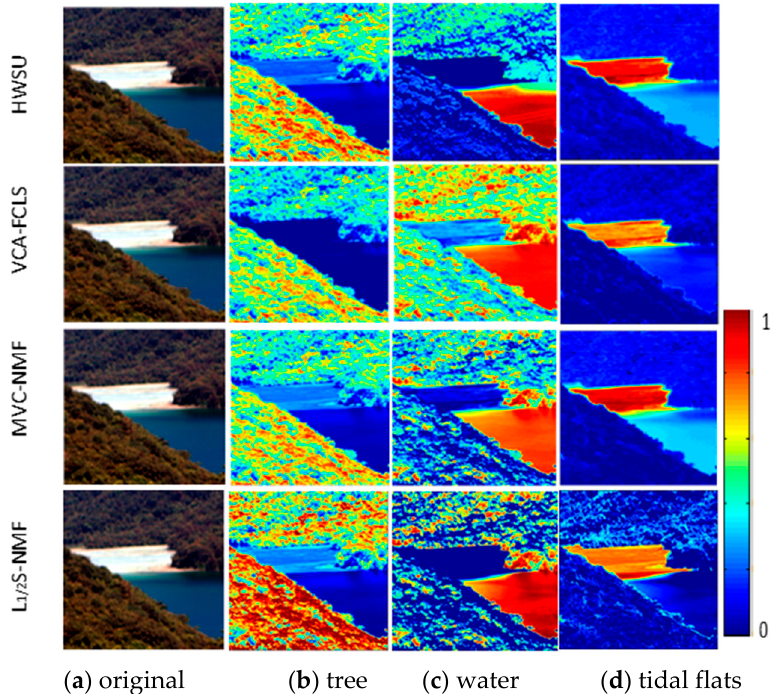
Figure 11. Abundance fraction results of Data 2 estimated by HWSU, VCA-FCLS, MVC-NMF, L 1/2 S-NMF: ( a ) original image, ( b ) tree, ( c ) water, and ( d ) tidal flats.